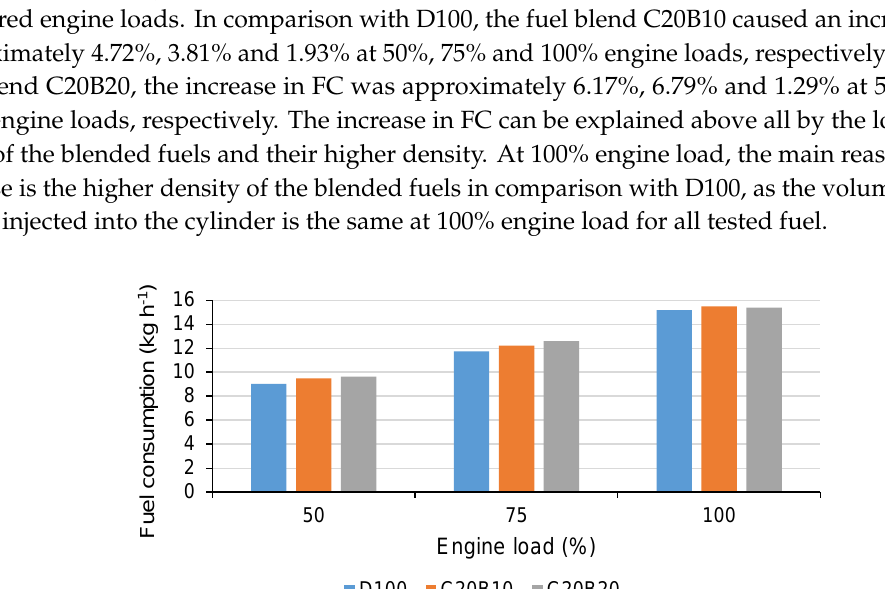
Figure 8. Brake torque for all tested fuels at all measured engine loads (error bars represent the standard deviation).